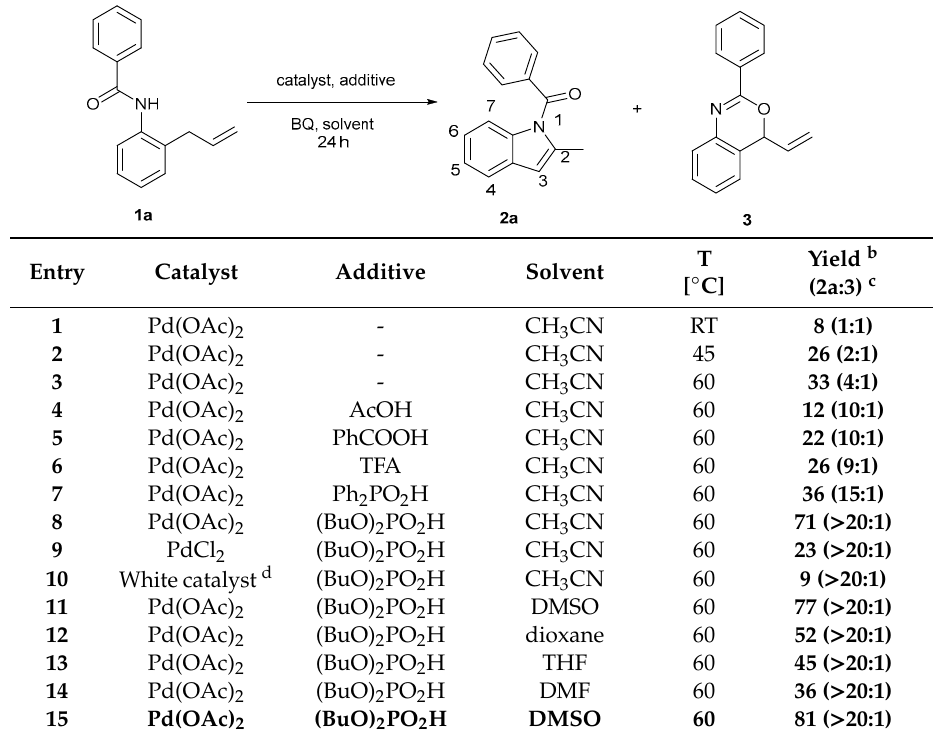
Table 1. Optimization of the Reaction Conditions. a.